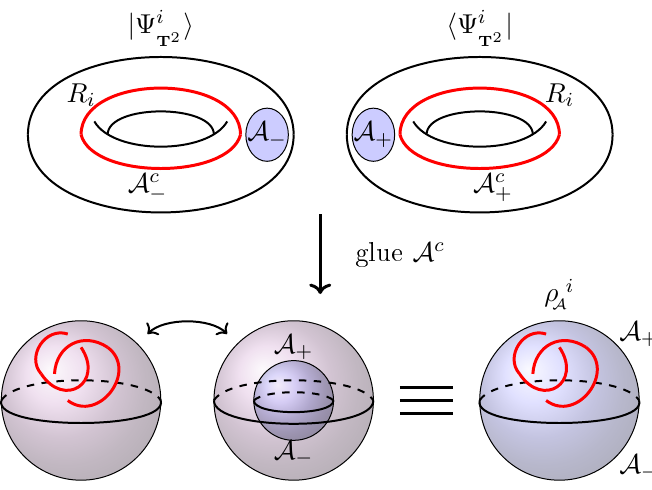
i from the state j (cid:9) i i and h (cid:9) i j for regions A T 2 T 2